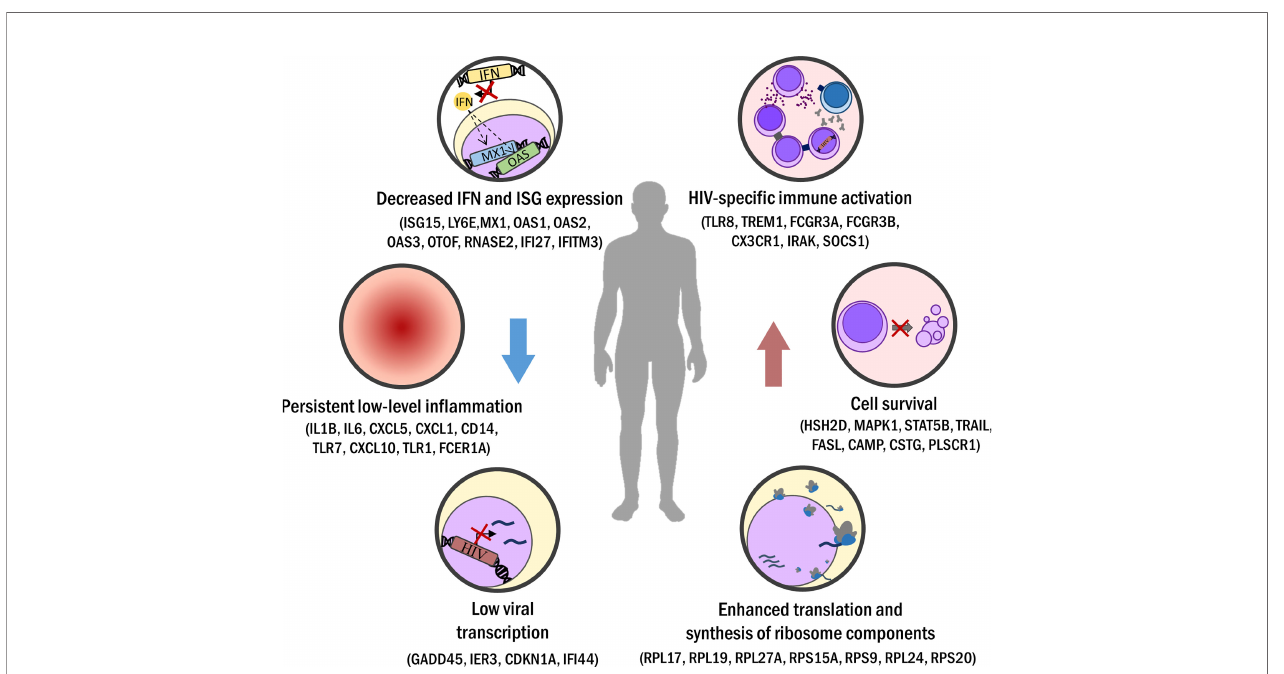
FIGURE 1 | Biological processes commonly seen in elite control or long-term non-progression. Minor activation of sustained immune response (i.e. downregulated IFN response) leads to persistent but low in fl ammation levels in EC/LTNP. Viral transcription is lessened in EC but also in LTNP. Increased HIV-speci fi c cellular immune response is registered, driven by a strong Th1 CD4+ T helper activity and enhanced CD8+ T cells cytotoxicity and polyfunctionality. Apoptosis hindrance and favored expression of cell cycling pathways improve cell survival. Also, ribosome component amount and protein synthesis are increased in